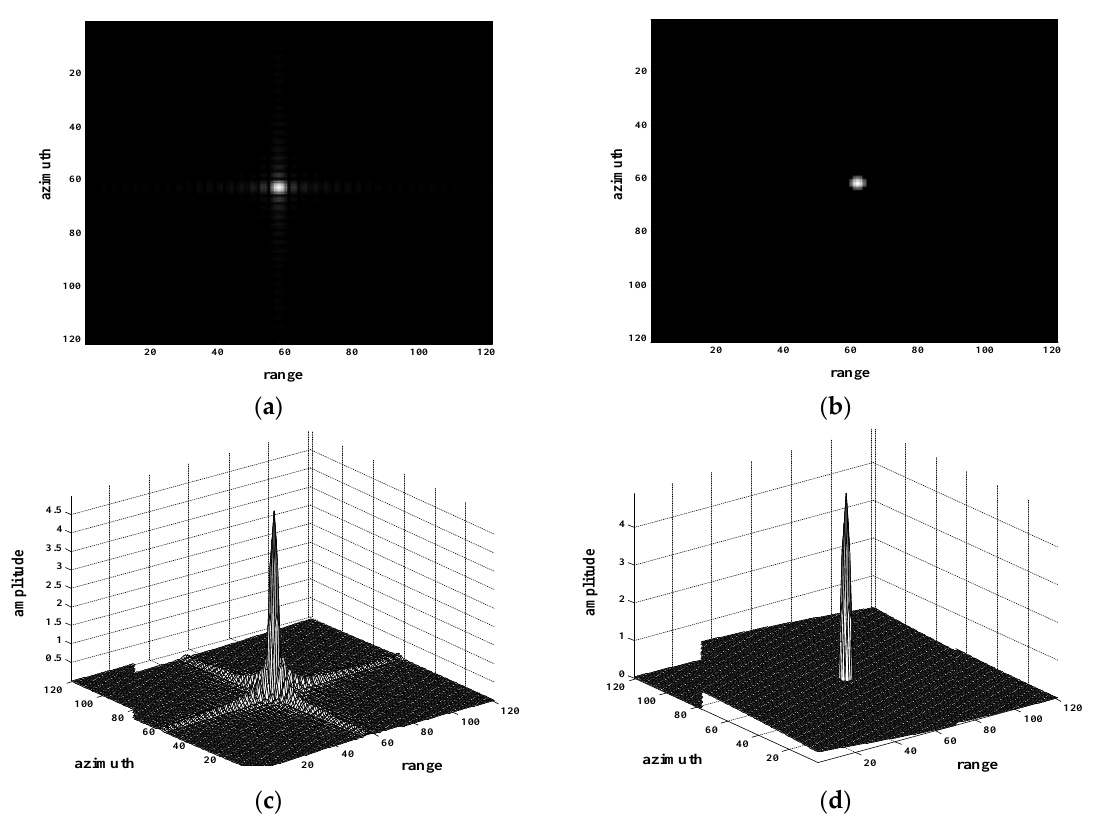
Figure 2. Experiment of point target ( a ) Imaging result of single-point target through conventional MF-based algorithm; ( b ) reconstructed image of (a) through the proposed method; ( c ) three-dimensional map of point target in (a); ( d ) three-dimensional map of reconstructed image in (b).